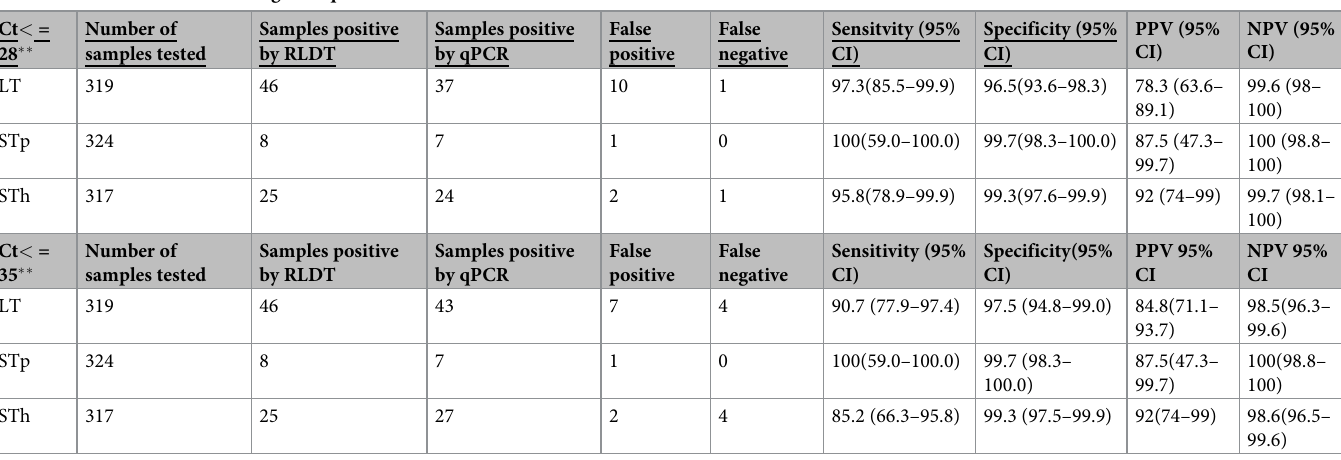
Table 2. Performance of RLDT against